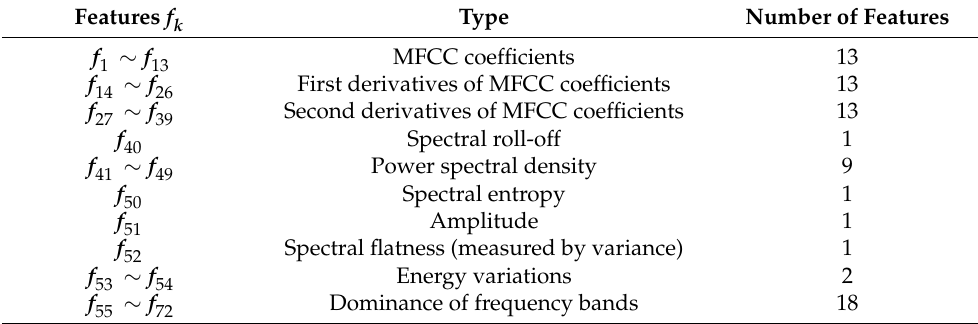
Table 2. Summary of extracted